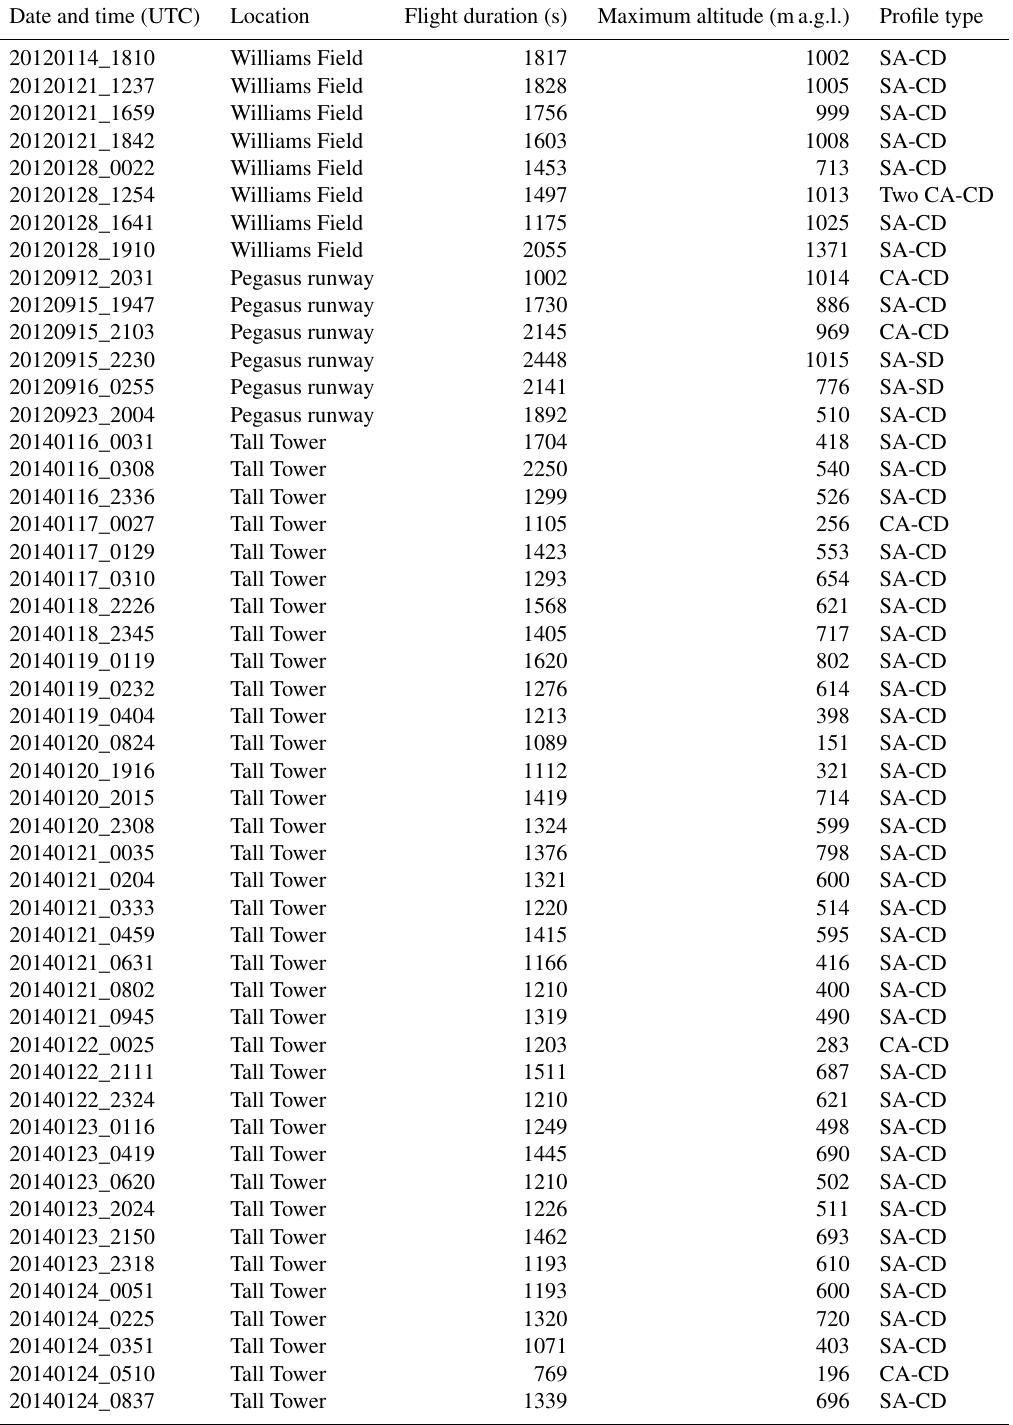
Table A1. UTC date and time (yymmdd_HHMM format; yy: year; mm: month; dd: day; HH: hour; MM: minute), location, flight duration (s), maximum altitude above ground level (a.g.l.) and profile type (SA: stepped ascent; CA: continuous ascent; SD: stepped descent; CD: continuous descent) for all SUMO